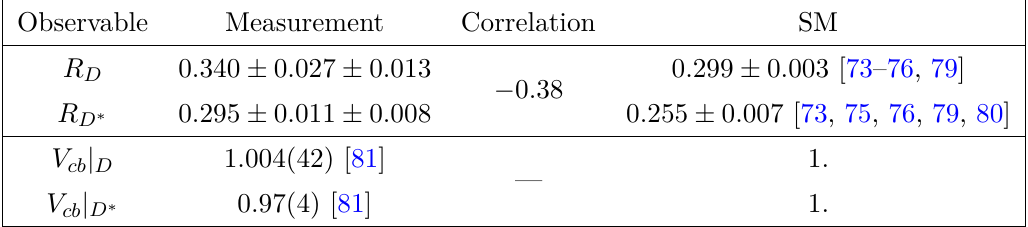
Table 2 . Experimental measurements, SM predictions and correlations for b → c